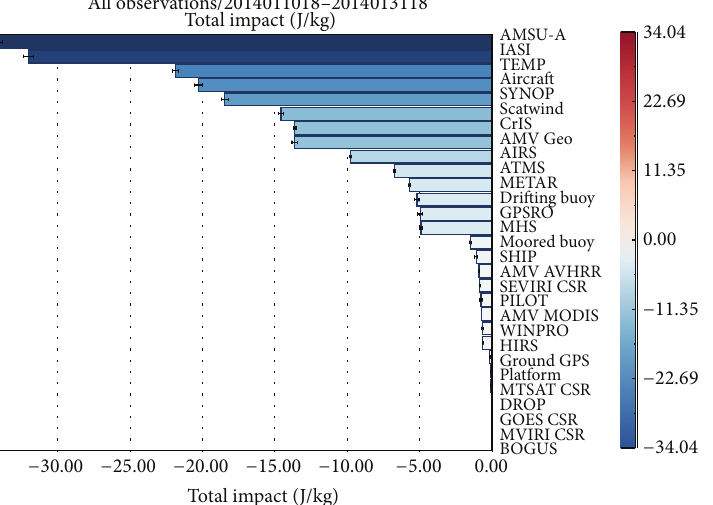
Figure 13: Total impact of all assimilated obs. in the Met Office DA system. Magnitude of ATMS contribution is about a fifth of that from 5 AMSU-A instruments (January